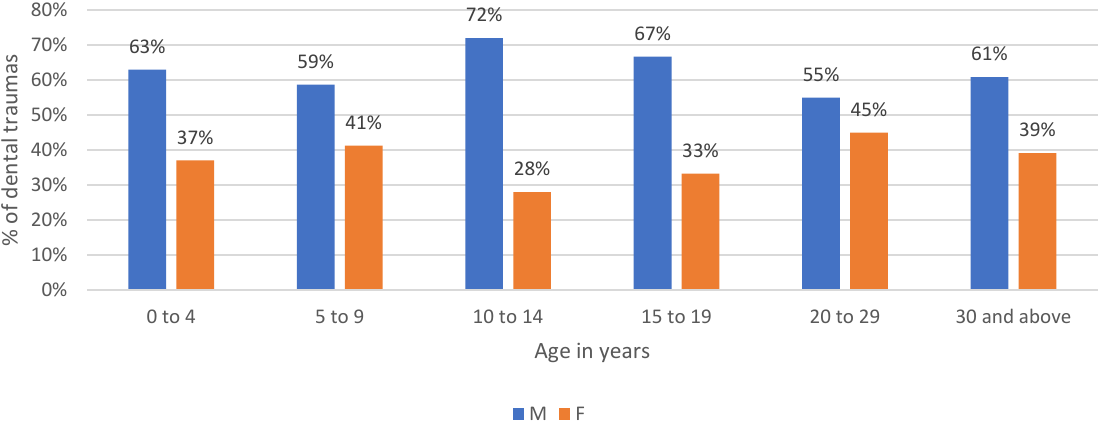
Figure 2. Distribution of traumatic dental injuries in relation to age and gender. Table 1. Number of injured teeth for each Three ‐ hundred and six patients presented dental injuries, with a total of 480 teeth impacted (59% deciduous, 41% permanent); 23 patients had soft tissue wounds, and 4 patients sustained mandibular fractures. injuries (up to one tooth) more often in comparison to adults (Table 1).